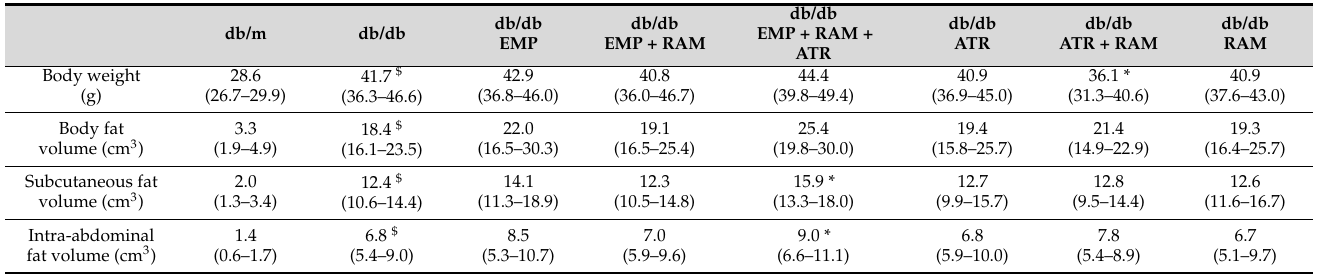
Table 1. Body weight, body fat volume, and fat distribution at the end of the experiment of vehicle- treated db/m mice, vehicle-treated db/db mice, and db/db mice treated with empagliflozin, atrasen- tan, ramipril, or their combinations.